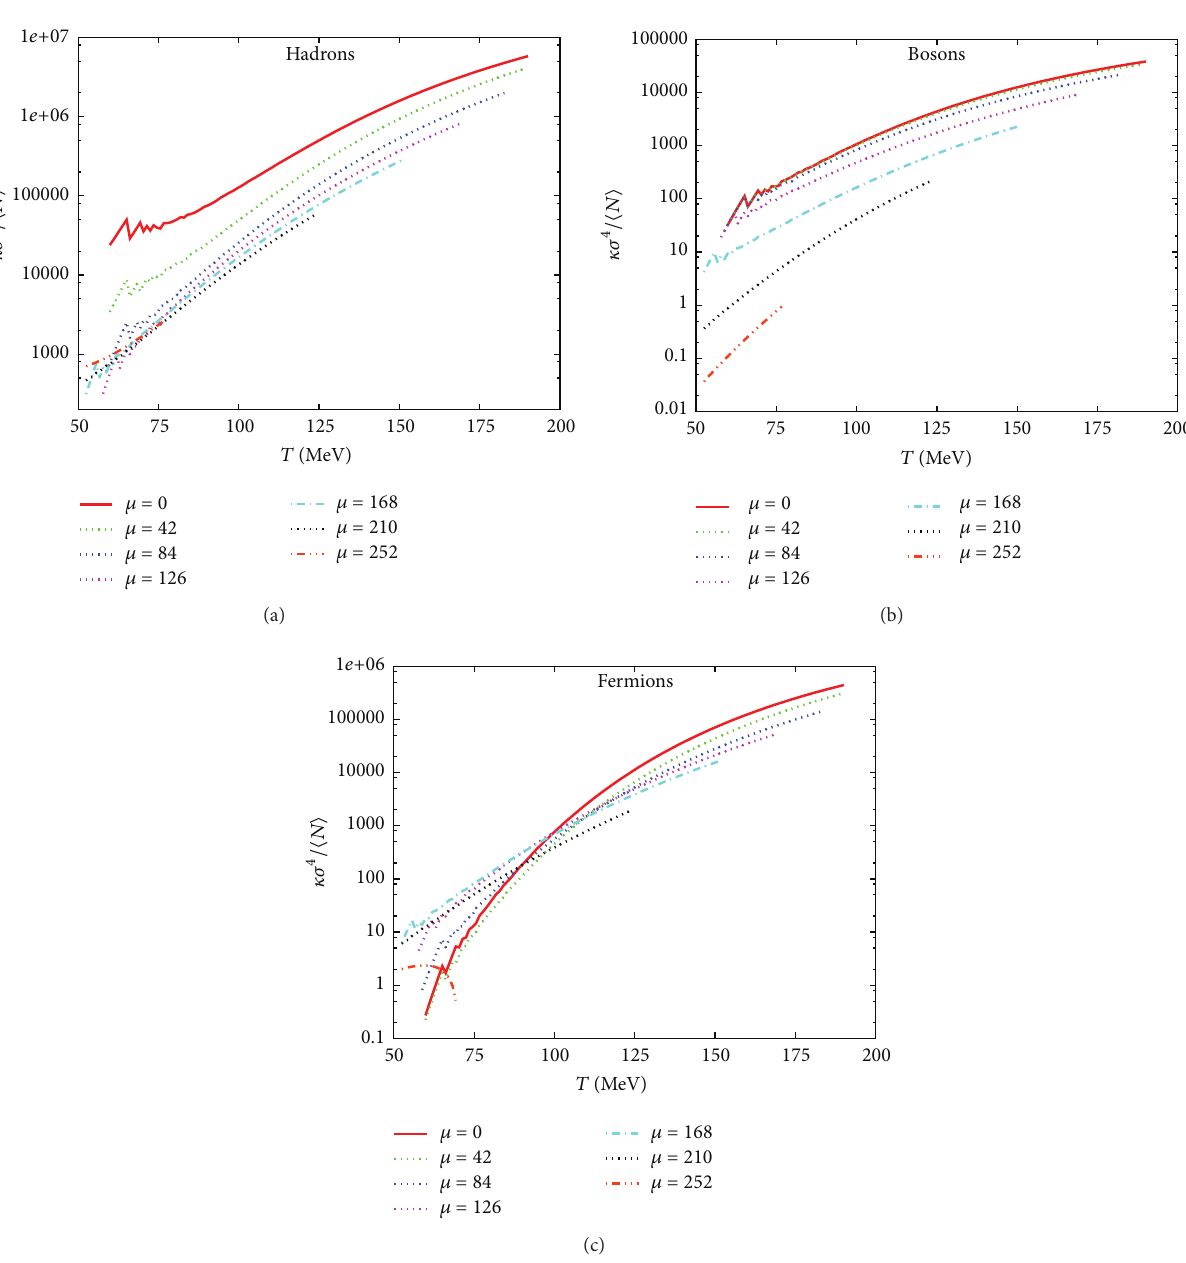
ones. We concluded that going from lower to higher order moments is possible through adding up a series that consists of all lower order moments plus correlation functions.